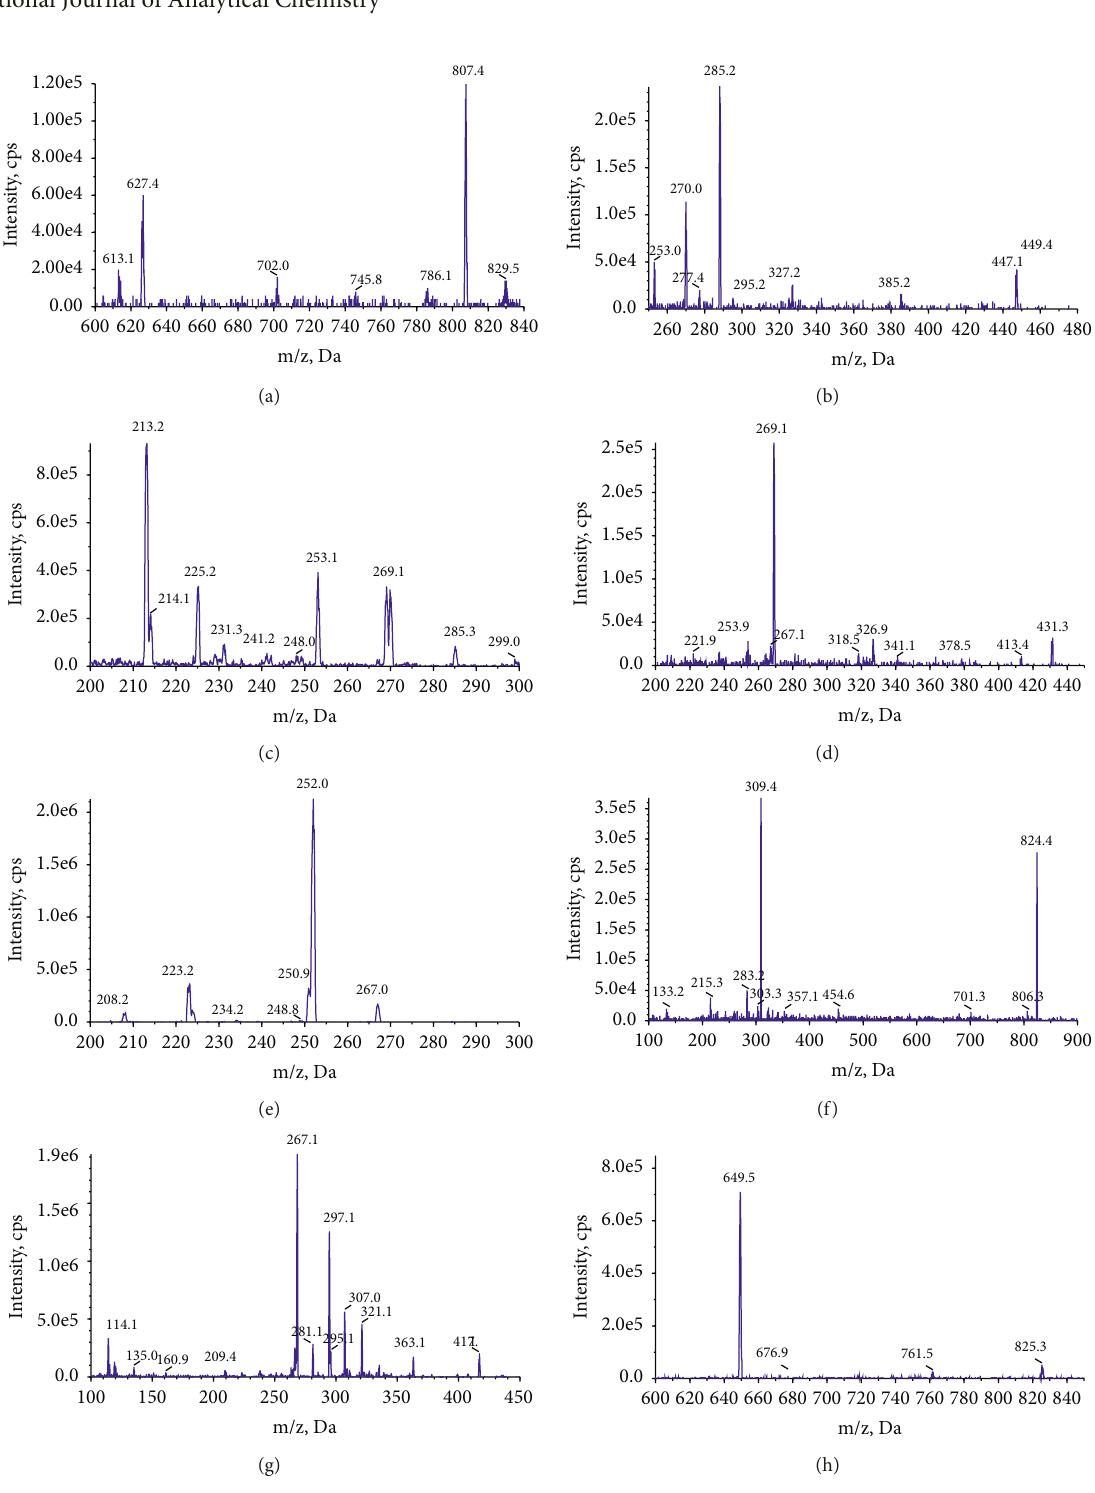
Figure 2: The mass spectra of six analytes. (a) Astragaloside IV, (b) calycosin-7-O- β -D-glucoside, (c) calycosin-glucuronide, (d) ononin, (e) formononetin, (f) glycyrrhetinic acid, (g) puerarin, and (h)